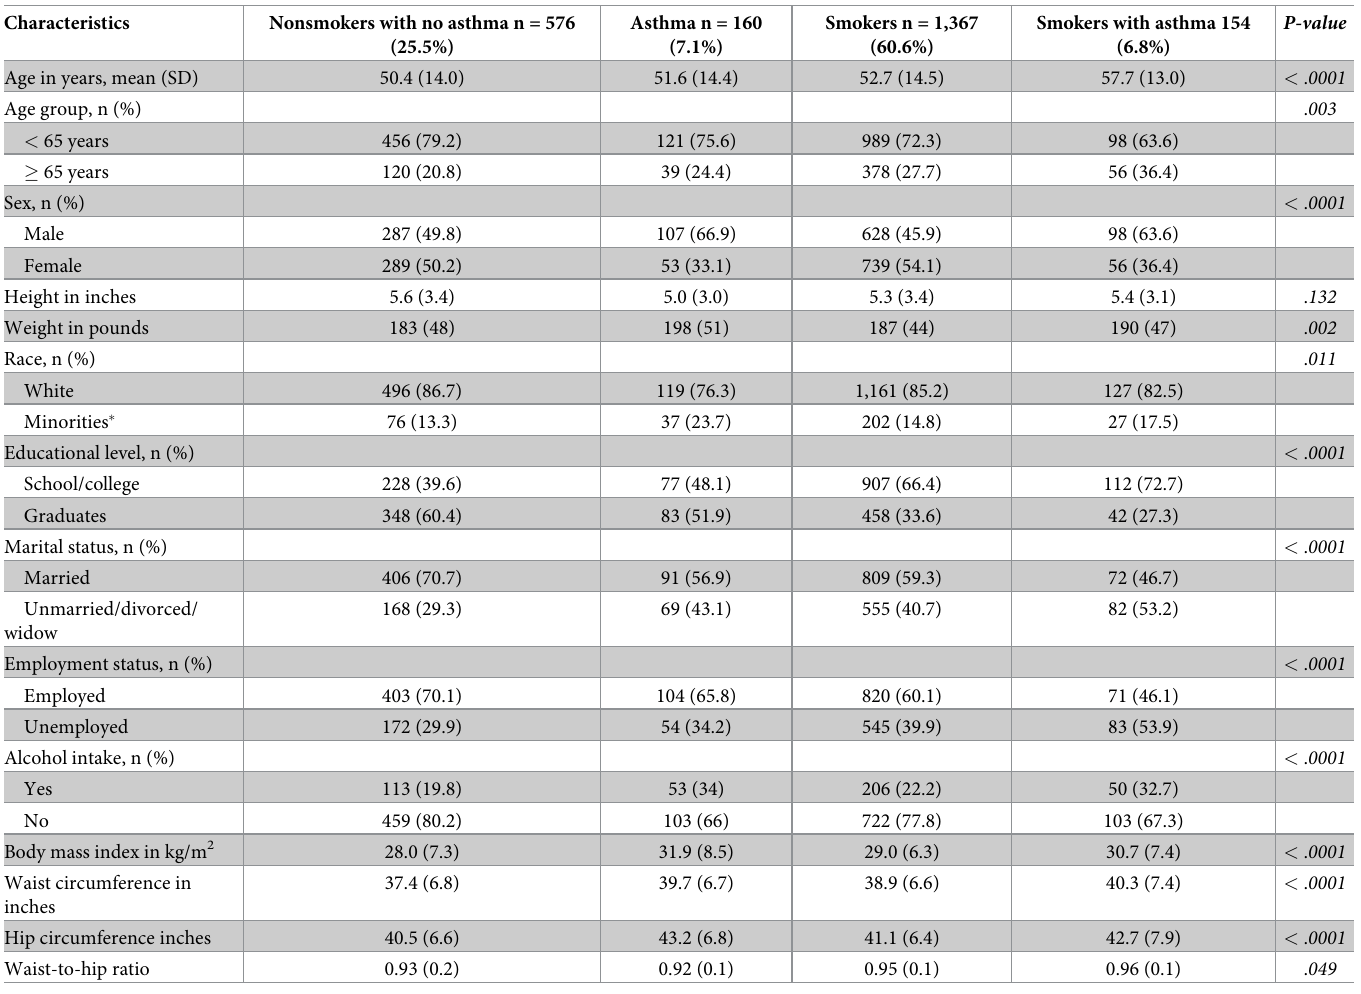
Table 1. Characteristics of the study sample. Characteristics